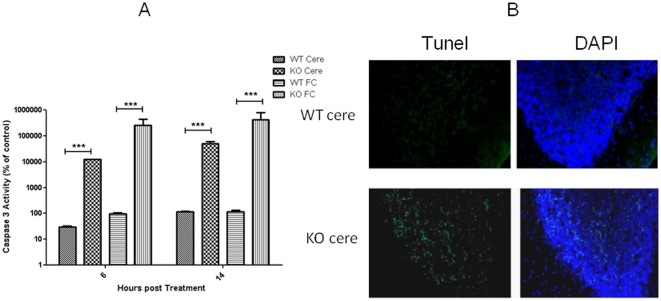
Increased sensitivity to trimethyltin in Hr knockout mice.Frontal cortex (fc) and cerebellum (cere) were isolated from brains of 25 day old knock out (KO) and wild type (WT) mice that were euthanized at 24 hrs after injection (i.p.) with 2.5 mg/kg trimethyltin. Caspase-3 activity was measured as described in figure 1 (A) in homogenates. *** p<0.001. To conduct terminal transferase-mediated biotinylated-UTO nick end-labeling (TUNEL) staining, mice were perfused with PBS/4% formaldehyde and the brains were post-fixed in the same buffer. Brains were made hyperosmotic with sucrose and sections (25 microns) were stained for TUNEL (green) and nuclei were stained with DAPI. The granule layer of the cerebellum is shown (B).